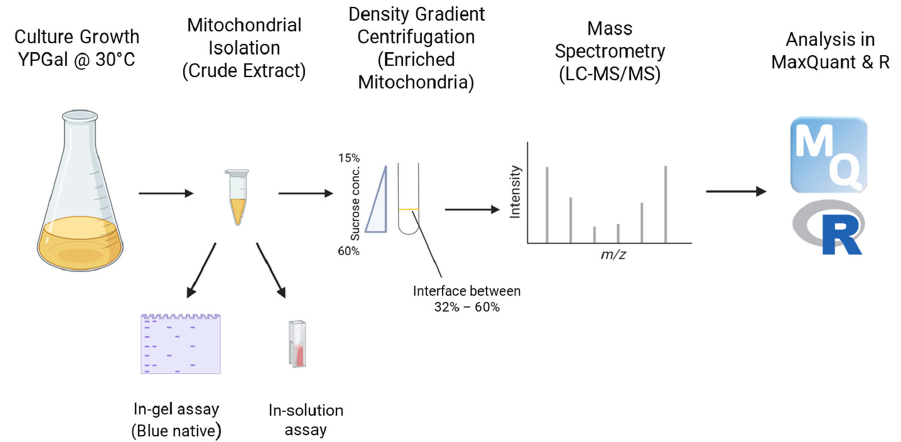
Figure 1. Workflow for mitochondria isolation, activity and proteomics analyses for the WT and Δ yme1 samples.